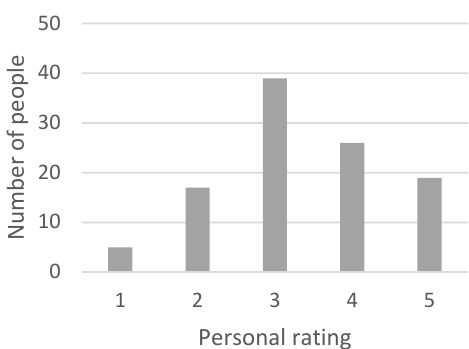
Figure A8. Perceived personal knowledge on recycling scheme in Borås, first survey (106 individuals).